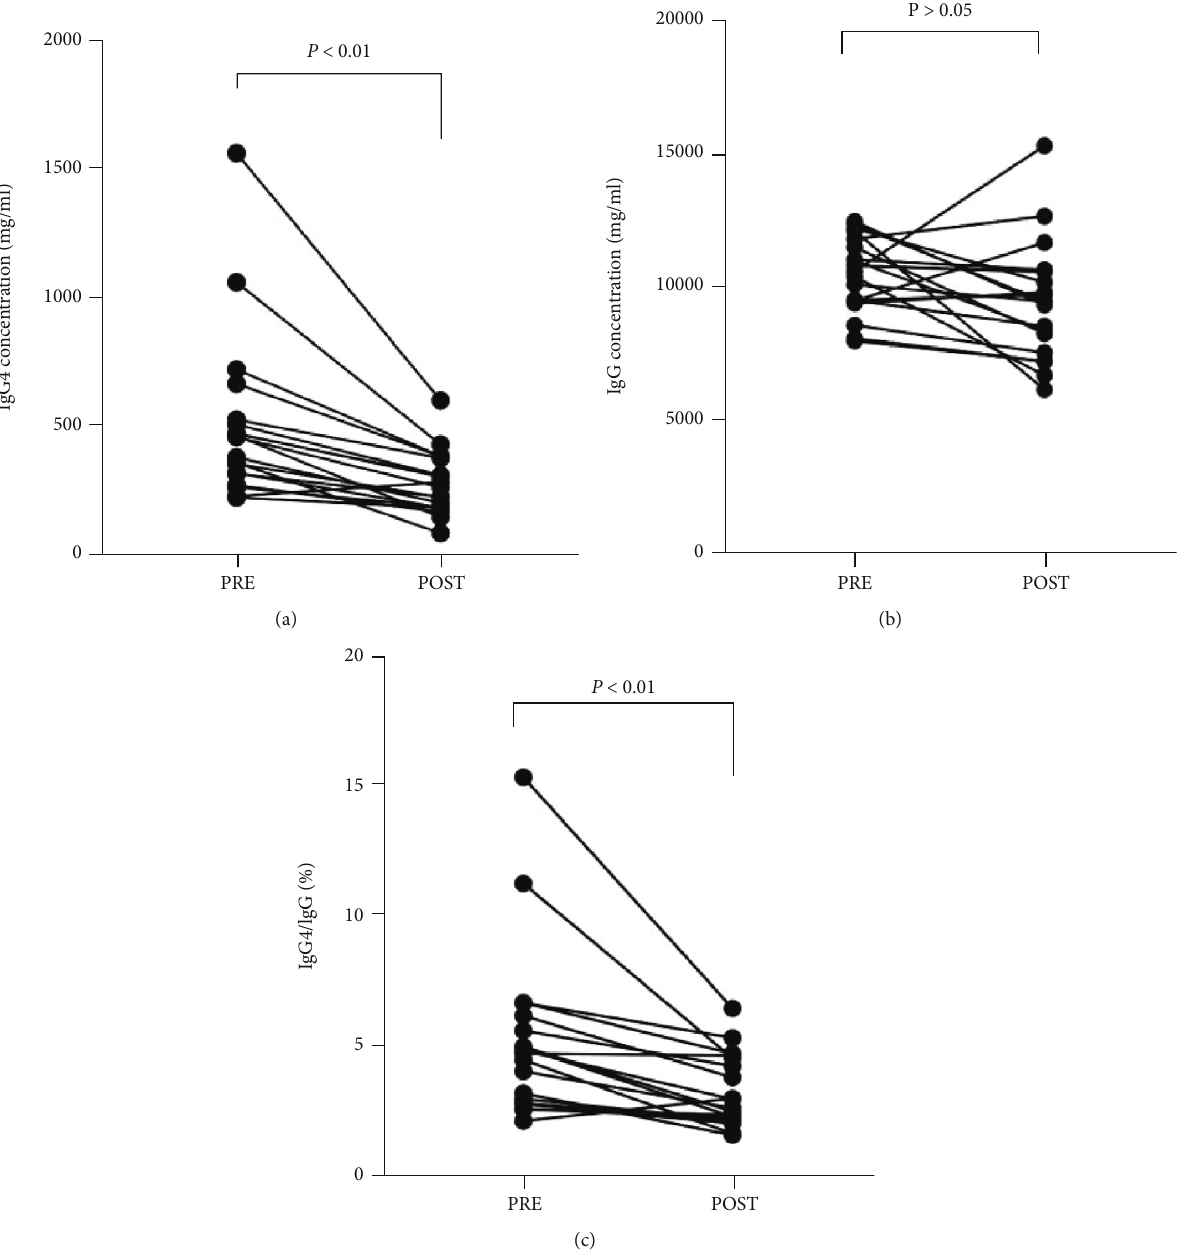
Figure 4: The change of serum IgG of newly diagnosed MDS-AI (PRE) and post-therapy (POST). (a) The change of serum IgG4 of newly diagnosed MDS-AI (PRE) and posttherapy (POST). (b) The change of serum IgG of newly diagnosed MDS-AI (PRE) and posttherapy (POST). (c) The fraction of serum IgG4/IgG of newly diagnosed MDS-AI (PRE) and posttherapy (POST) ( n = 19